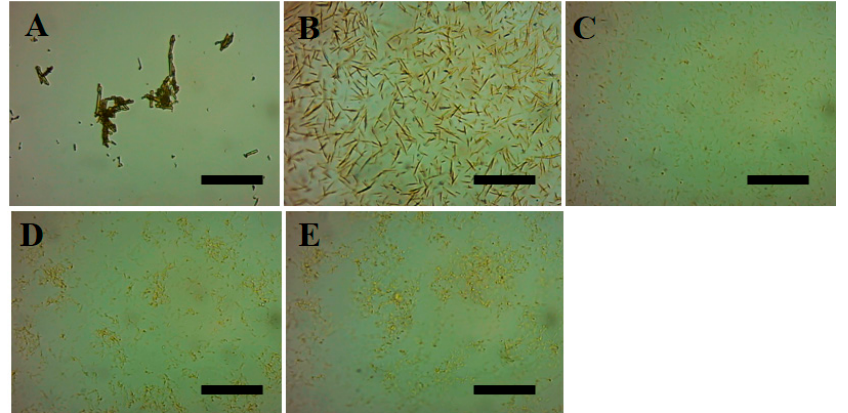
Figure 2. Light microscopic images of native quercetin particles dispersion ( A ) and quercetin particles dispersion formed by antisolvent precipitation with various antisolvent ratios (( B ), 1:1; ( C ), 1:2.5; ( D ), 1:5; ( E ), 1:10). The scale bar is 50 µm.